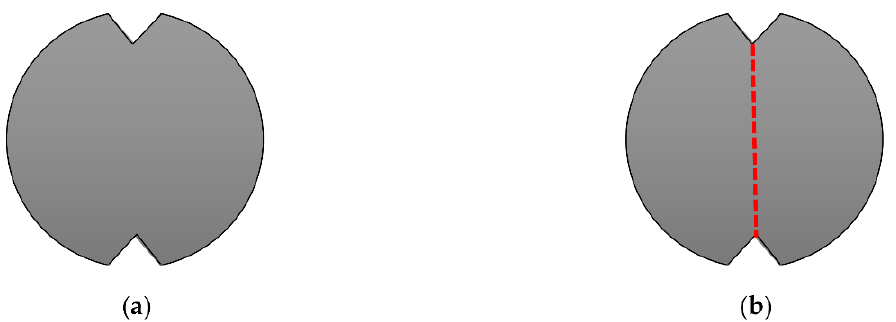
Figure 9. Suggested end-notched specimen of Badr and Ashour [73]: ( a ) end triangular notches and ( b ) accepted cracking path.